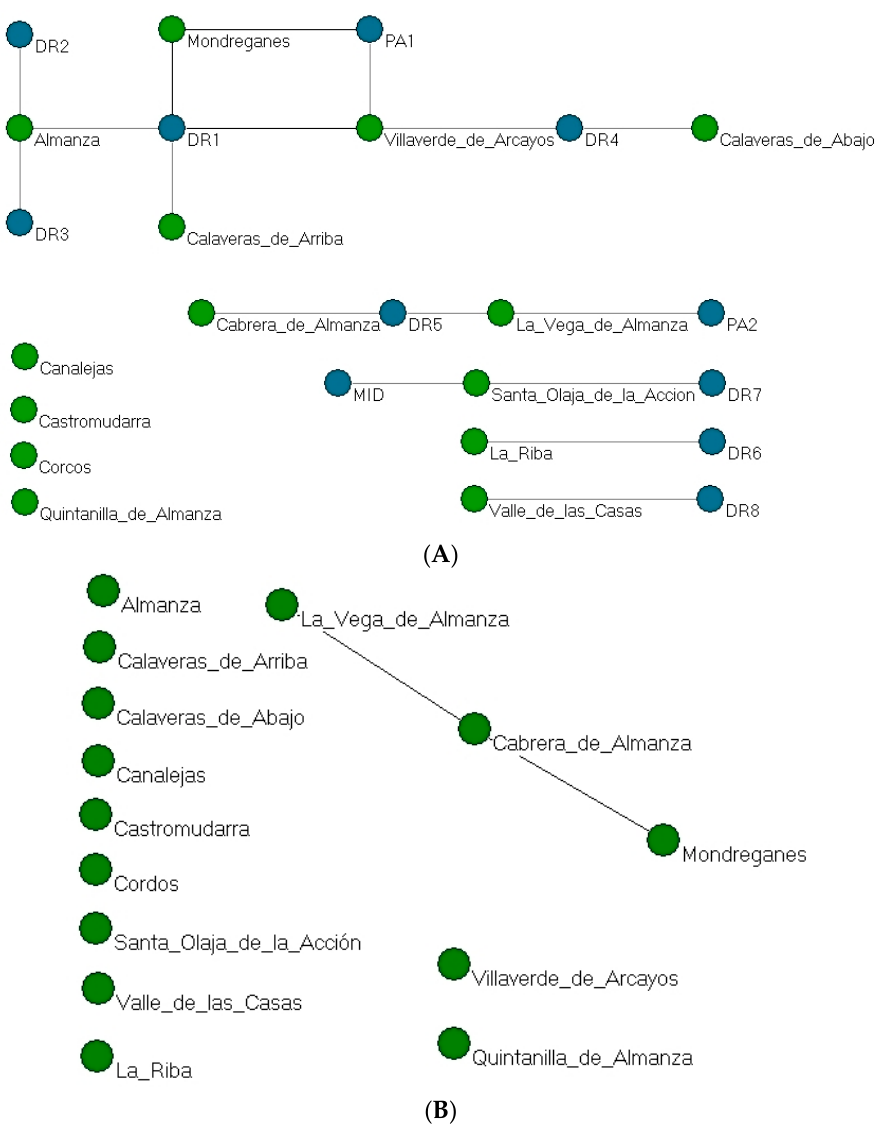
Figure 7. ( A ) Two-mode network of municipalities in which deliveries occurred and the health professionals who attended them (blue: health professionals; green: localities); ( B ) One-mode network of municipalities according to co-occurrence of deliveries attended by health professionals.